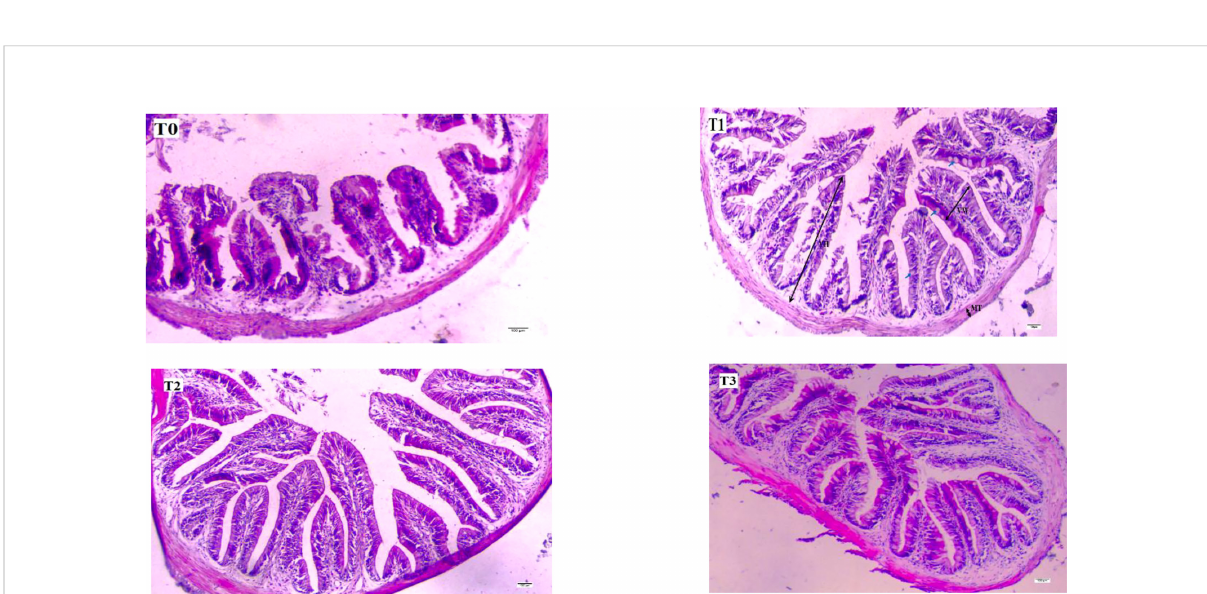
FIGURE 2 Effect of different scales of FT on the morphology of the mid-gut of the juvenile largemouth bass (X100, H&E staining, scale bar = 100( m m). Villi height (VH), villi width (VW), muscular layer thickness (MT), and the blue arrows indicated are goblet cells.